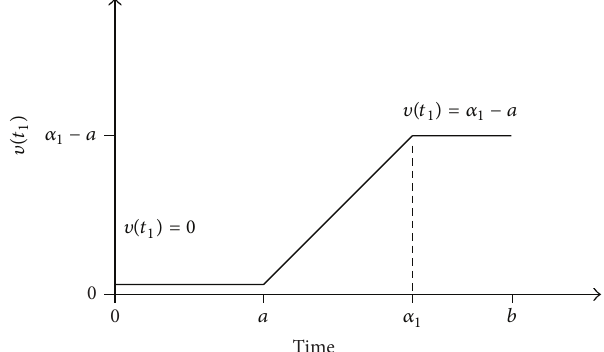
Figure 14: Clock evaluation of 𝑡 1 in a controlled TPN of Figure 10. The forbidden interval is ]𝛼 1 , 𝛼 2 ] where 𝑎 < 𝛼 1 < 𝛼 2 ≤ 𝑏 .